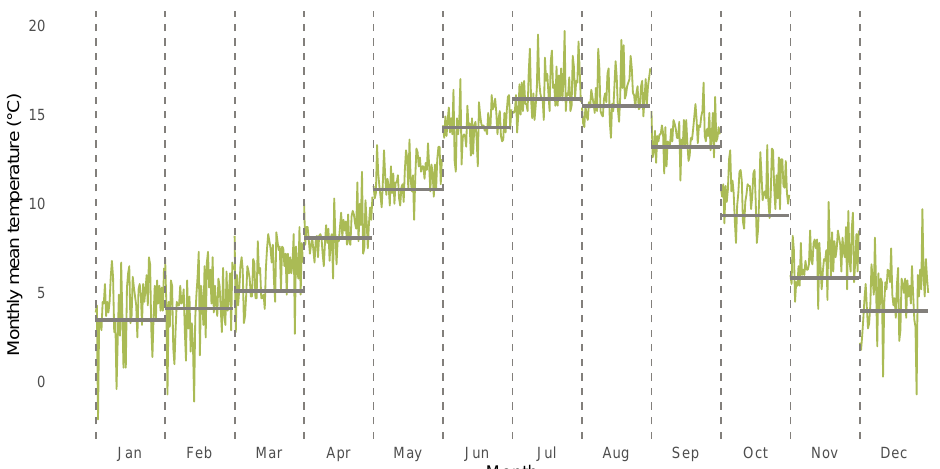
Figure 3. CET data for each month from 1961 until 2020. From left to right, months January to December are displayed over the years. Grey lines indicate monthly mean temperature from 1850 until 1900. Different months separated by dashed vertical